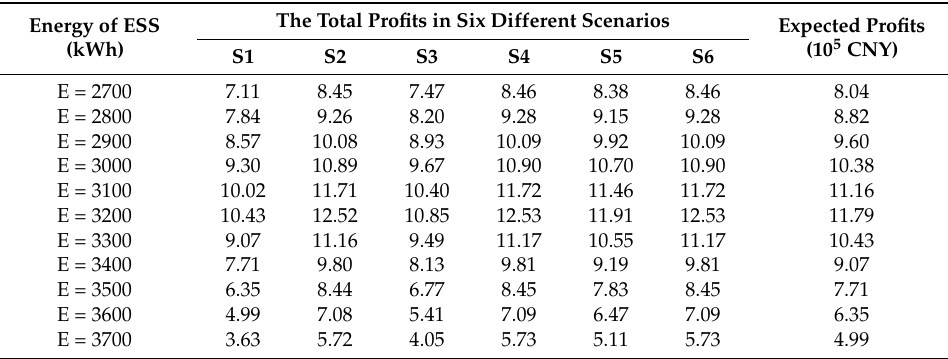
Table 5. The total profits in different scenarios and capacity of energy storage.